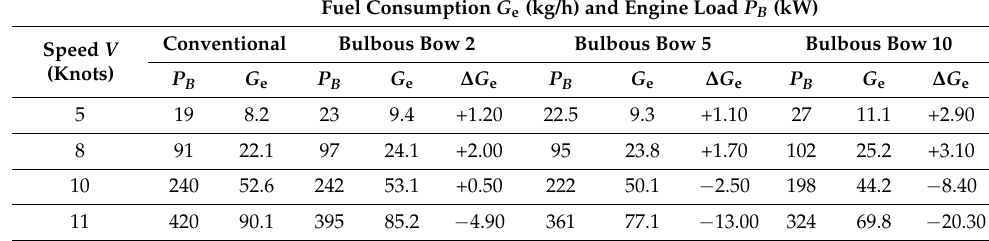
Figure 9. The results of the NOx, CO and CO 2 emissions calculations are presented in Tables 6–8. Table 5. Fuel consumption G e (kg/h) and engine load P B (kW) at different speeds of the vessel for selected bulbous bows.